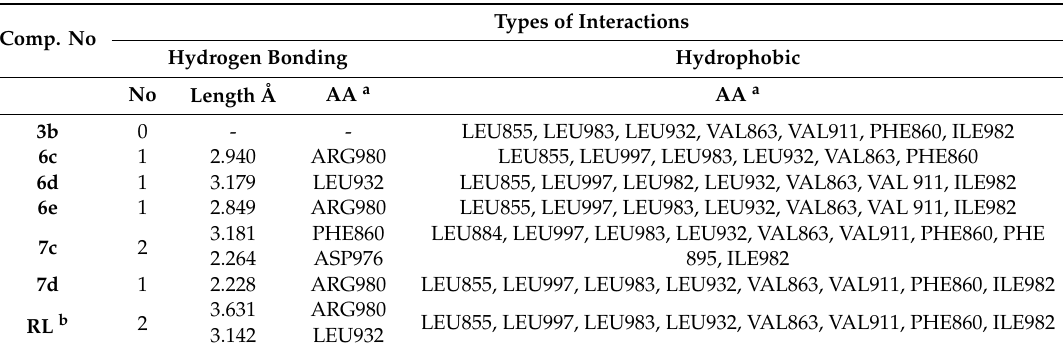
Table 4. Hydrogen bond and hydrophobic interaction for the most promising tested compounds into Jak2 binding pocket in comparison to the co-crystallized ligand.